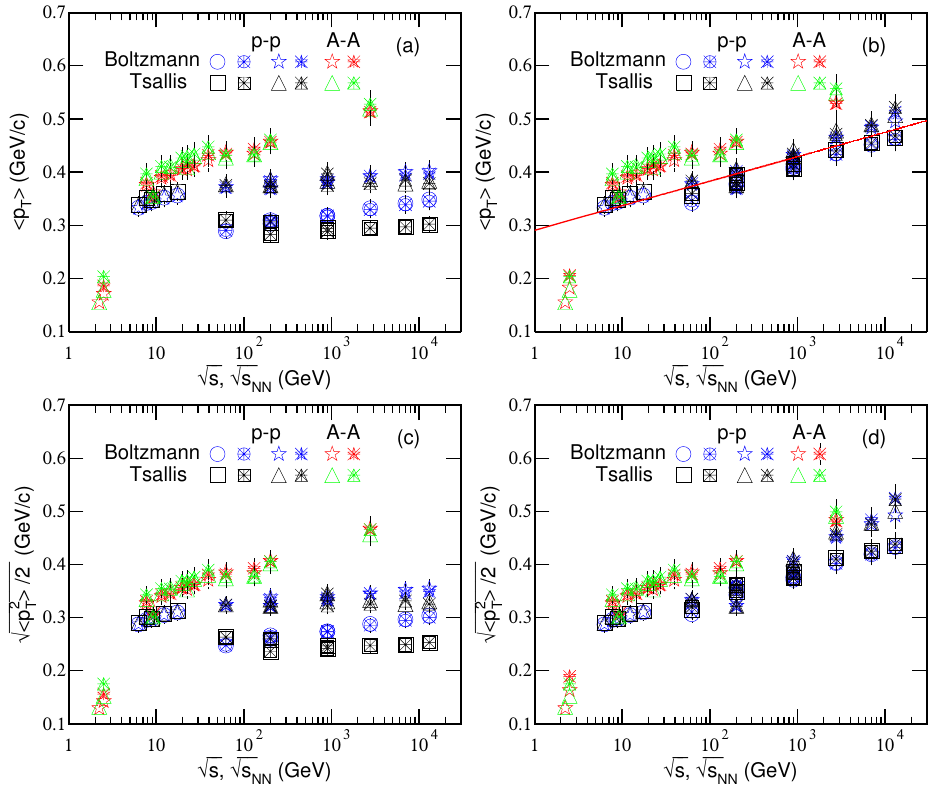
(cid:113) (cid:104) p 2 (cid:105) /2. The open symbols (open symbols with Figure 3. Excitation functions of ( a , b ) (cid:104) p T (cid:105) and ( c , d ) T asterisks) represent the values corresponding to π − ( π + ) spectra. The blue circles (black squares) represent the results obtained indirectly from Equations (1) and (2) for the left panel, or from Equation (7) through Equations (1)–(3) for the right panel, by the first set of parameter values. The results by the second set of parameter values are presented by the blue asterisks (black triangles). These values are indirectly obtained according to the parameter values listed in Tables 1 and 2. The lines are the fitted results for various symbols for pp collisions. The red asterisks (green triangles) represent the results from AA collisions for comparisons, which are indirectly obtained according to the parameter values listed in Tables A1 and A2 in the Appendix